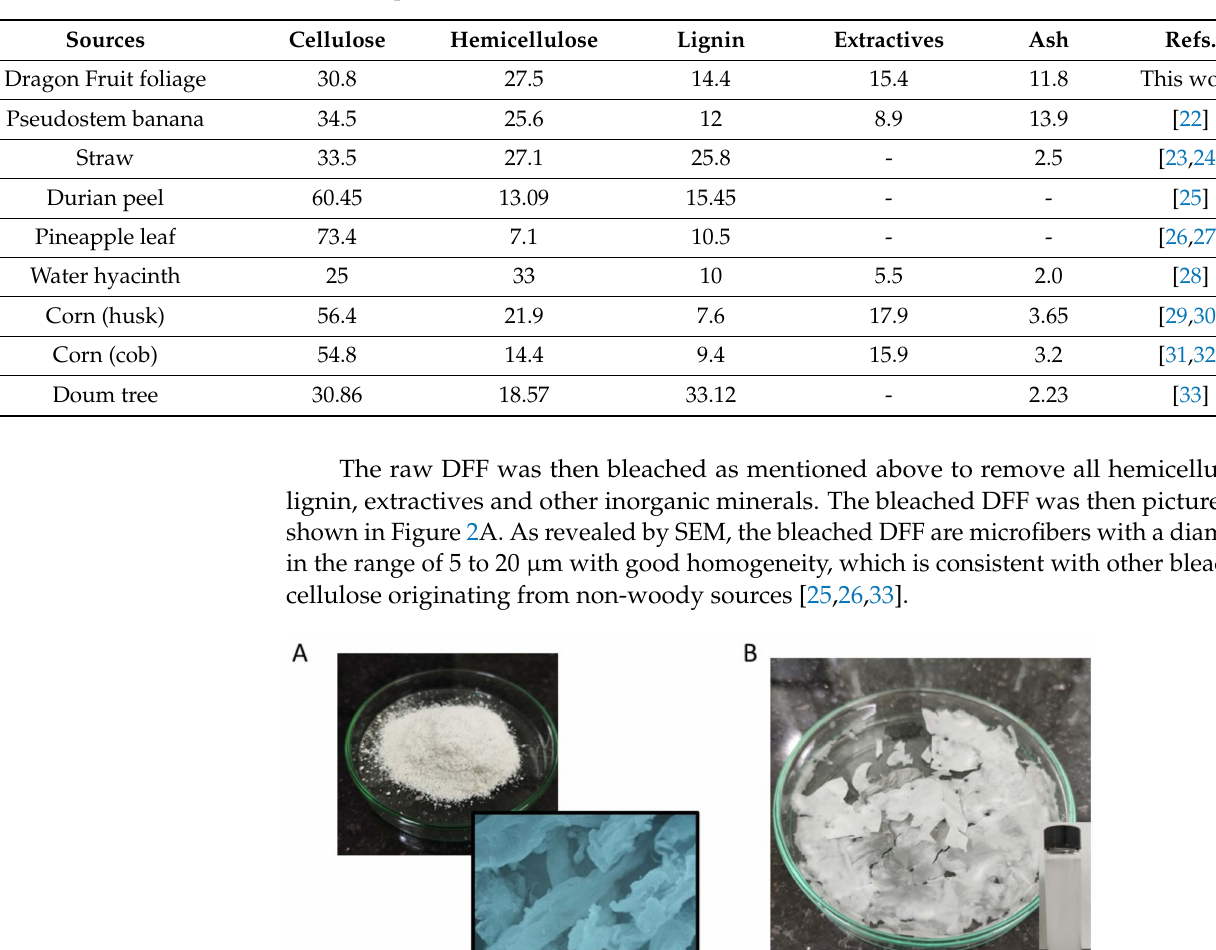
Table 1. Chemical composition of the studied DFF source and several cellulosic materials.